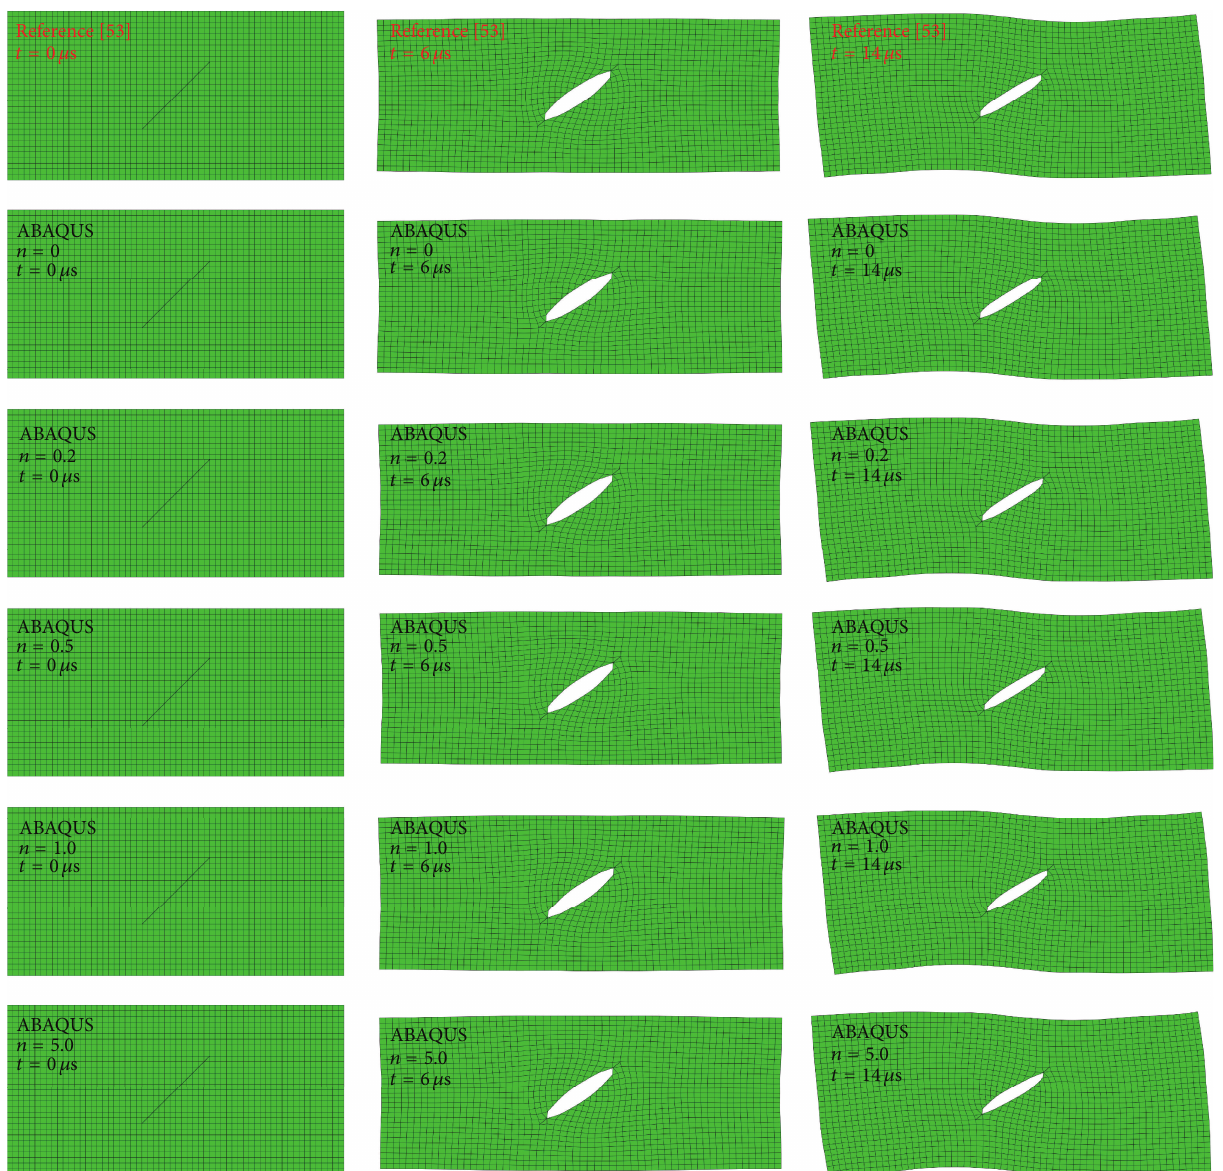
Figure 10: Different time steps of deformation figures of inclined-crack functionally graded